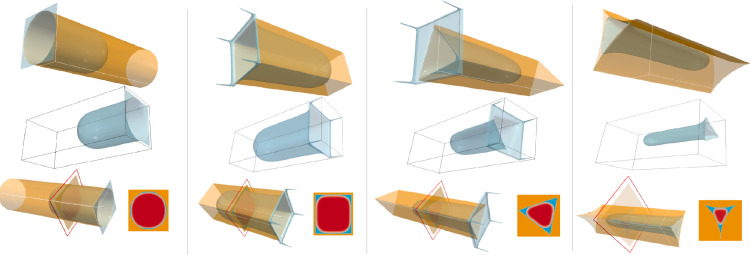
Geometry of the simulated capillary tubes. From left to right: circular, square, triangle and curved boundaries cylinders. On the top row the cylindrical solid walls are displayed translucent to show the interface shape. The middle row illustrates the meniscus shape inside the cylinder. The solid walls are removed for clarity. The bottom row shows the phase distribution in each cylindrical cross-section. The wetting phase (displayed in blue) is retained differently in the corners depending on the cross-sectional shape.